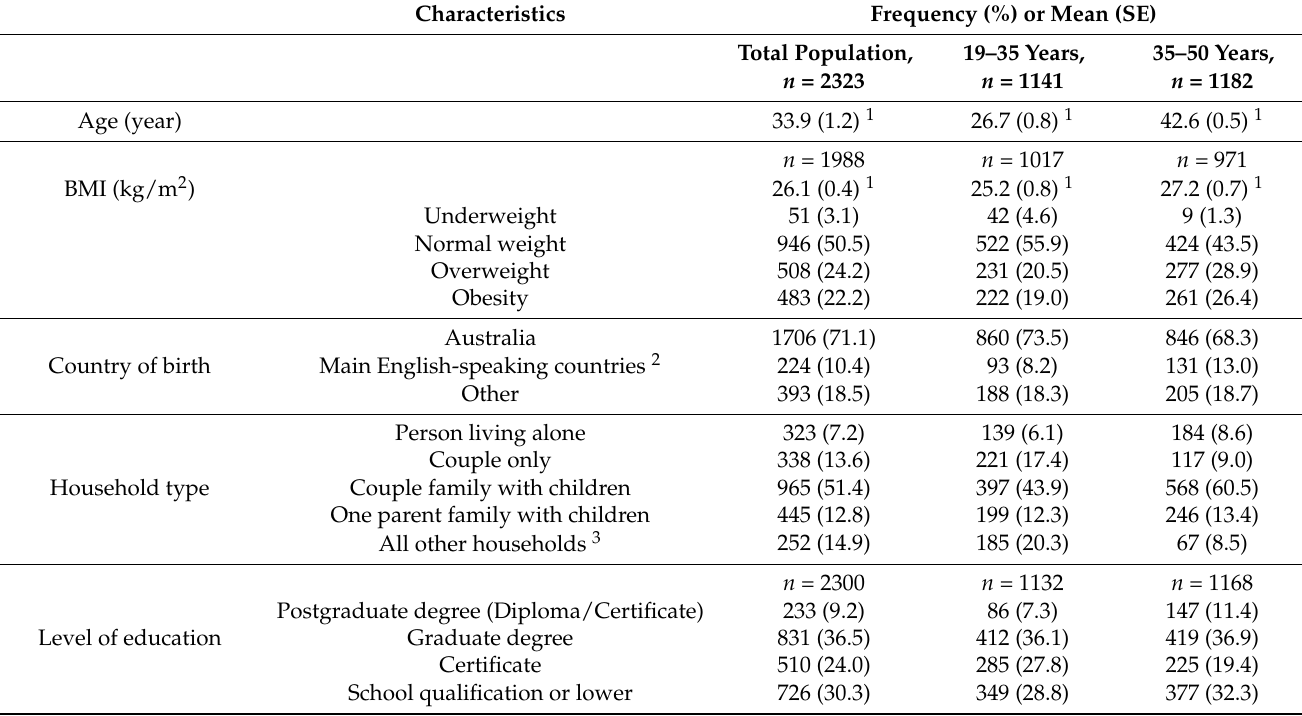
Table 1. Characteristics of reproductive age women participating in the Australian Health Survey, Nutrition and Physical Activity,